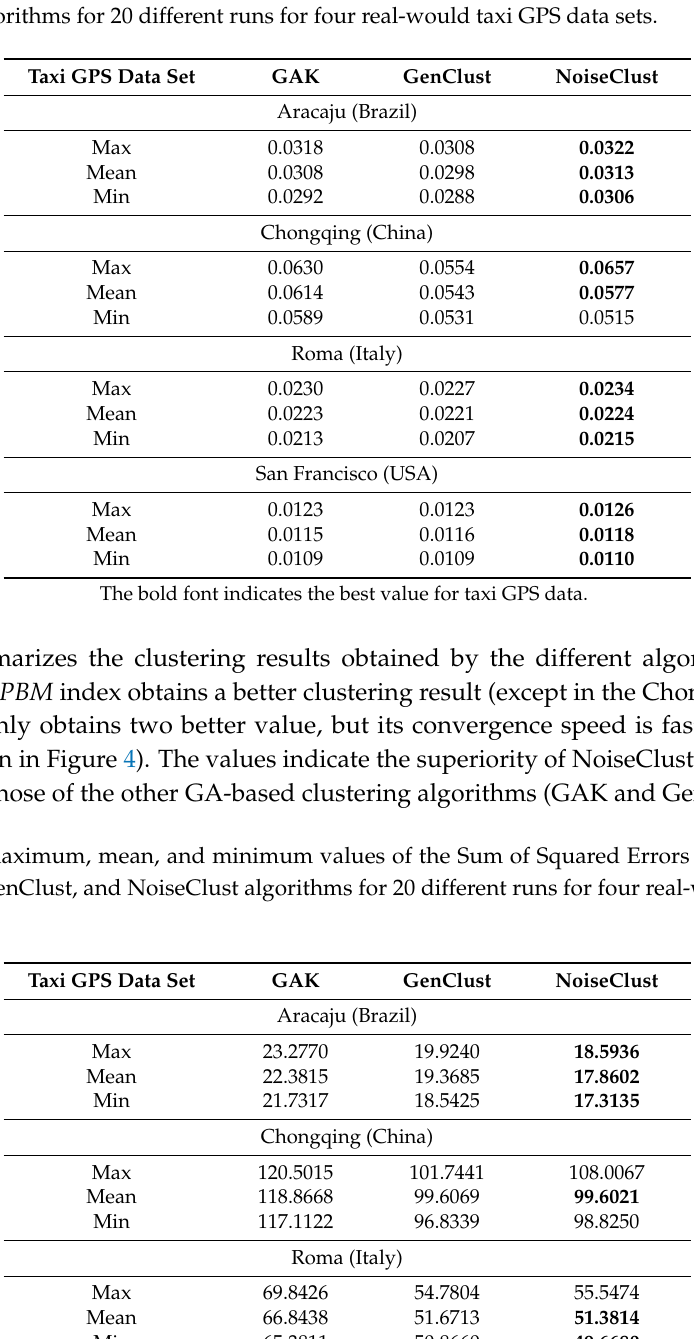
Table 3. The maximum, mean, and minimum values of PBM obtained by the GAK, GenClust, and NoiseClust algorithms for 20 different runs for four real-would taxi GPS data sets.